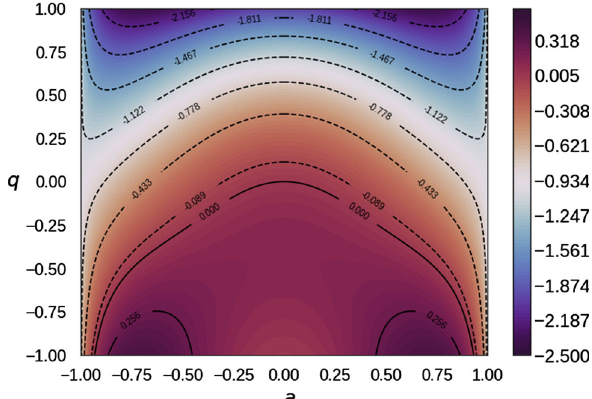
Fig. 2 The behavior of the relativistic quadrupole M 2 for different parameters a and